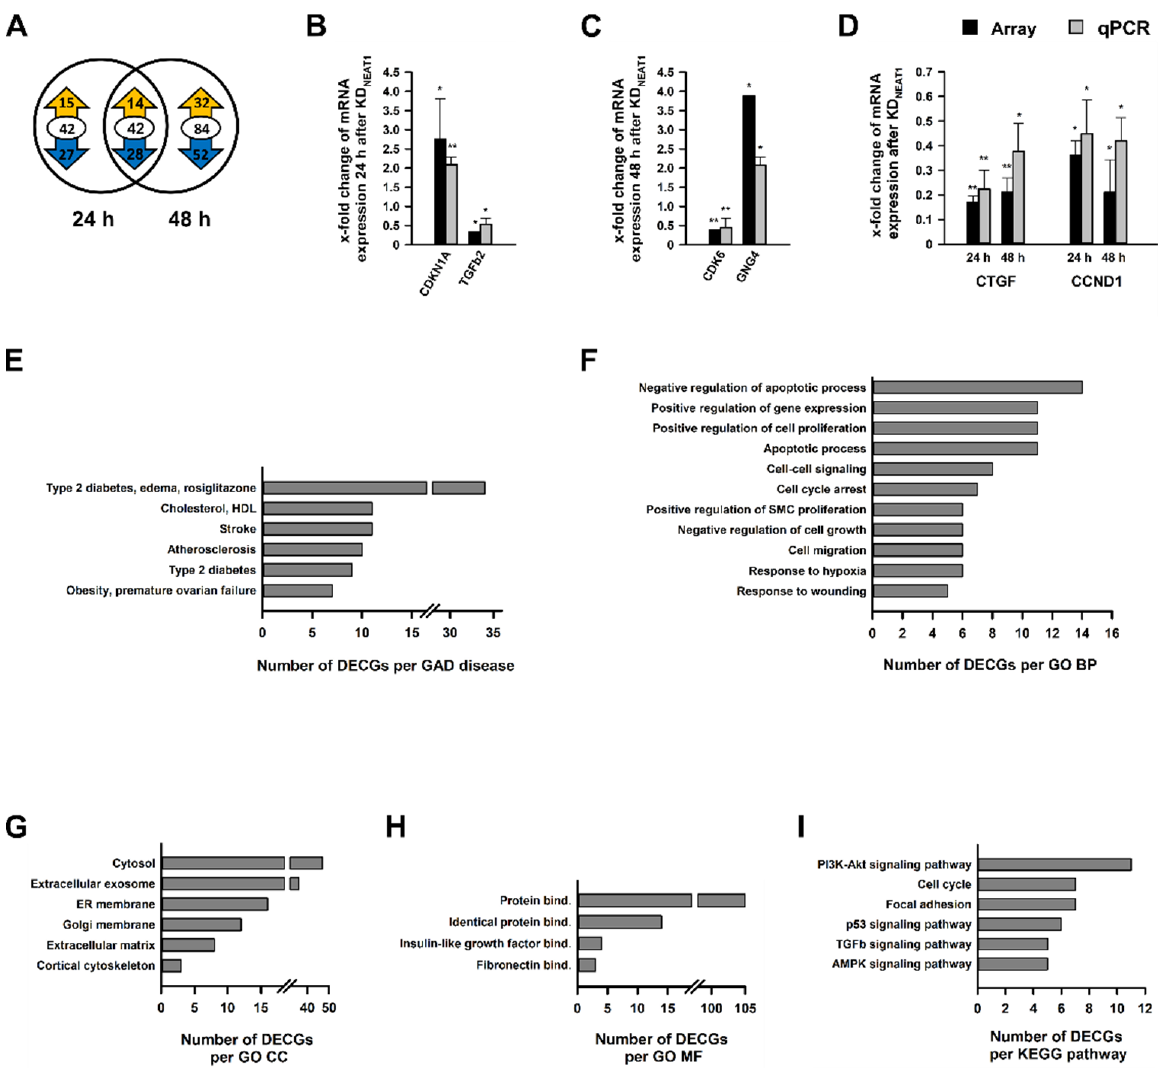
Figure 3. Analysis of differentially expressed coding genes (DECGs) in human mesangial cells (hMCs)